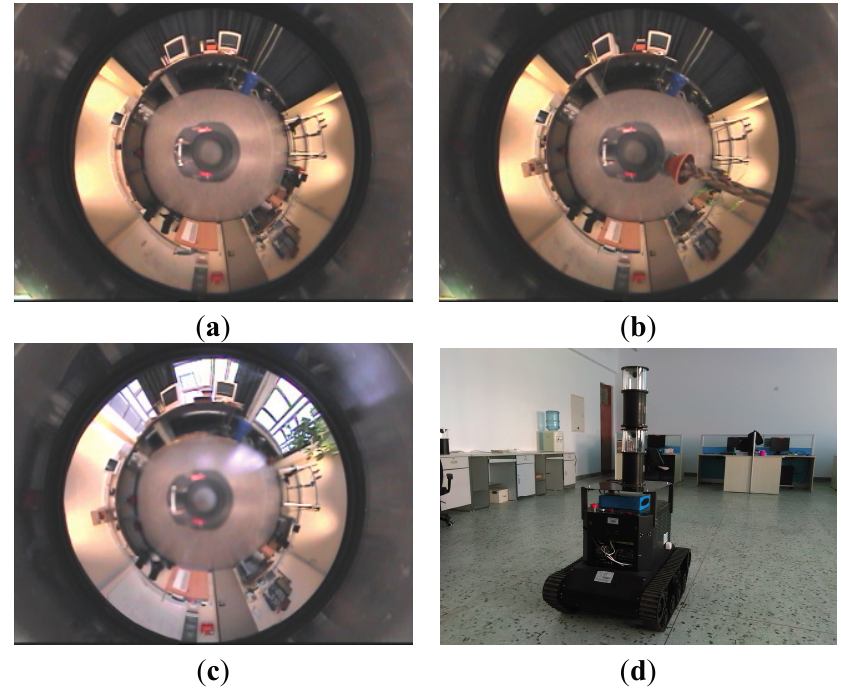
Figure 6. Panoramic sample images and robot platform. ( a – c ) The samples of three image databases: original, arboreal and day; ( d ) the robot platform for experiments in the real